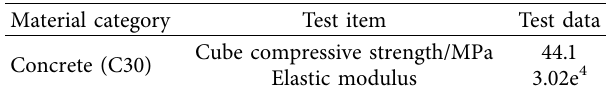
Table 3: Mechanical parameters of